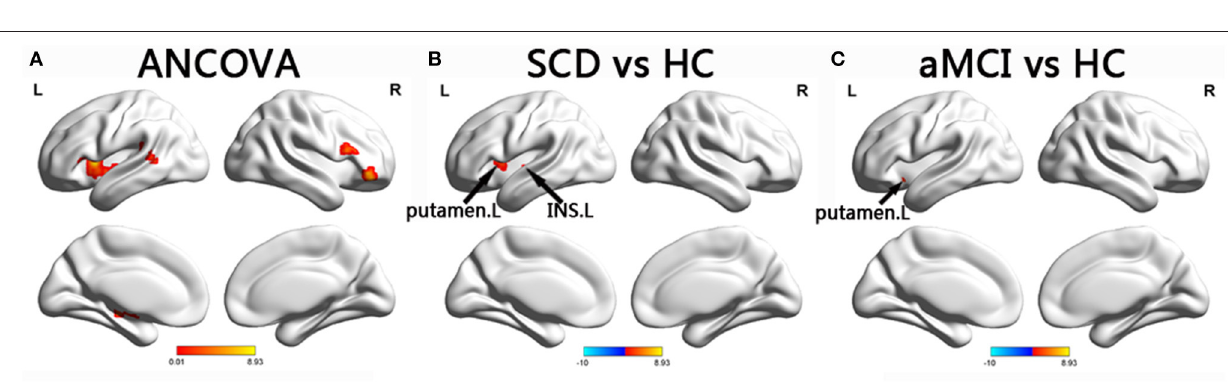
FIGURE 2 | Brain regions exhibiting significant differences in dynamic functional connectivity variability within default mode network. (A,C) Brain regions showing significant differences in dynamic functional connectivity variability within the anterior default mode network and posterior default mode network across three groups, including SCD, aMCI, and HC ( p < 0.05, the cluster size > 19 voxels). (B,D) Results of post hoc analysis in voxel-wise analysis (TFCE-FWE corrected, cluster size > 9, p < 0.05). aDMN, anterior default mode network; pDMN, posterior default mode network; aMCI, amnestic mild cognitive impairment; SCD, subjective cognitive decline; HC, healthy controls; AG, angular gyrus; SFG, superior frontal gyrus; MTG, middle temporal gyrus; R, right.